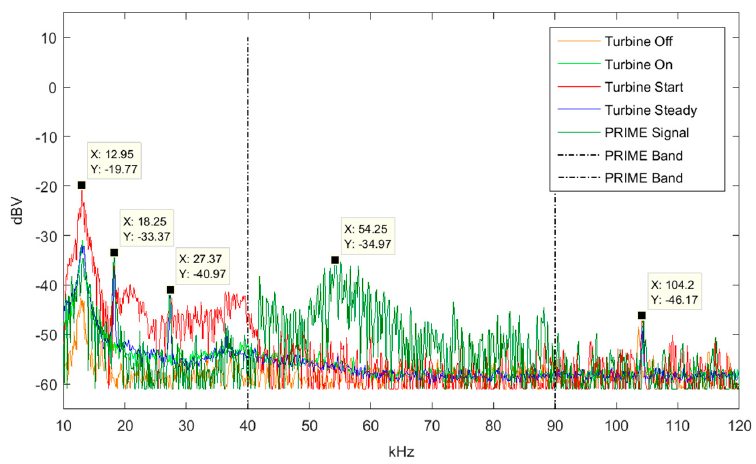
Figure 4. Spectrum recorded at the turbine SM with the rest of devices disconnected.